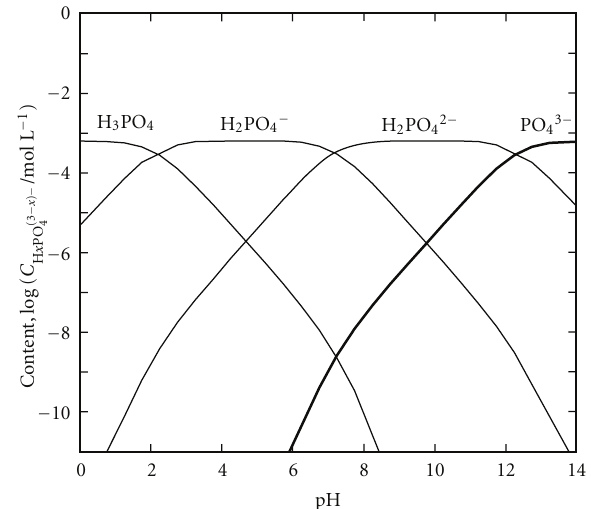
Figure 1: Logarithmic concentration diagram for orthophosphoric acid.